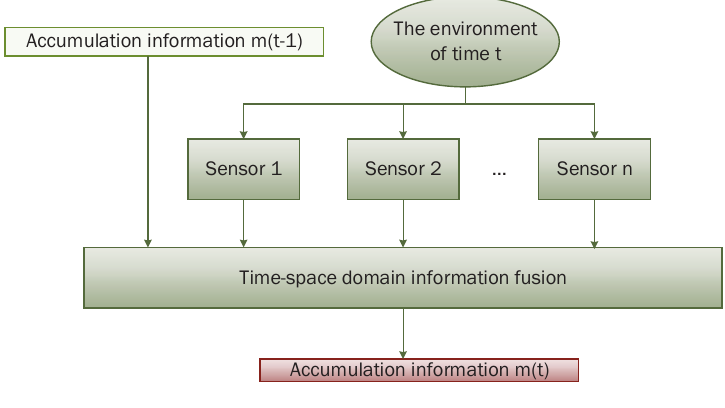
Figure 1. Recursive centralized